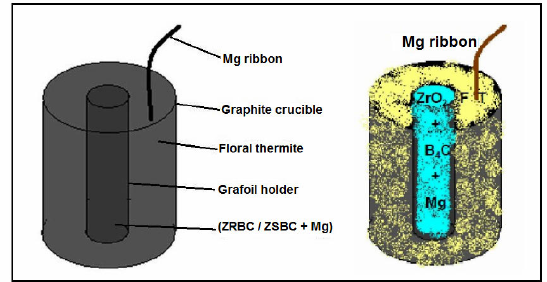
Fig. 1 Schematic diagram showing the arrangement of ZRBC powder samples for FT assisted reaction.